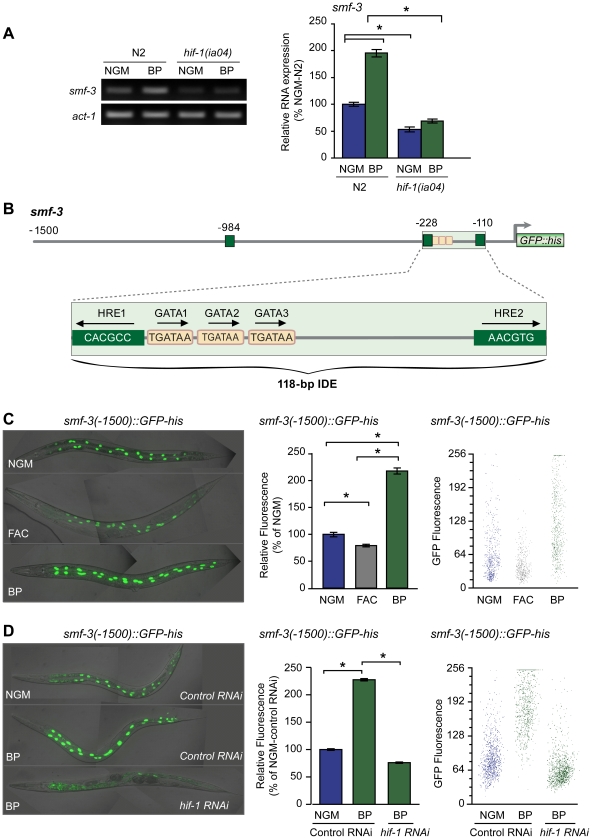
Activation of smf-3 during iron deficiency is dependent on an IDE in the smf-3 promoter.(A) smf-3 mRNA was quantified by RT-PCR in RNA isolated from N2 wildtype and hif-1(ia04) mutant strains cultured in NGM or NGM-BP for 16 h. Relative changes in smf-3 mRNA are expressed as a percentage of N2 wildtype animals cultured on NGM after normalization to act-1 mRNA. Five independent experiments were performed and the data are reported as means ± SEM, *p<0.0015. (B) Schematic diagram of the 5′ promoter region of the smf-3 gene. Small boxes, GATA binding motifs; large boxes, HREs. The IDE is enlarged showing HRE1, HRE2 and HRE3 and GATA1 and GATA2 sequences. Arrows indicate motif orientation. (C) Expression smf-3(-1500)::GFP-his containing 1.5 kb of promoter sequences in worms after culture in NGM, NGM-BP or NGM supplemented with FAC for 18 h. (D) Expression of smf-3(-1500)::GFP-his reporter in L4 animals fed control RNAi or hif-1 RNAi after culture in NGM or NGM-BP for 16 h. GFP fluorescence was quantified in (C and D) using the COPAS Biosort as described in Figure 1. Data are mean GFP fluorescence ±SEM as a percentage of untreated worms grown in NGM for (C) or as a percentage of worms fed control RNAi on NGM for (D), n = 1000 worms per treatment, *p<0.001.